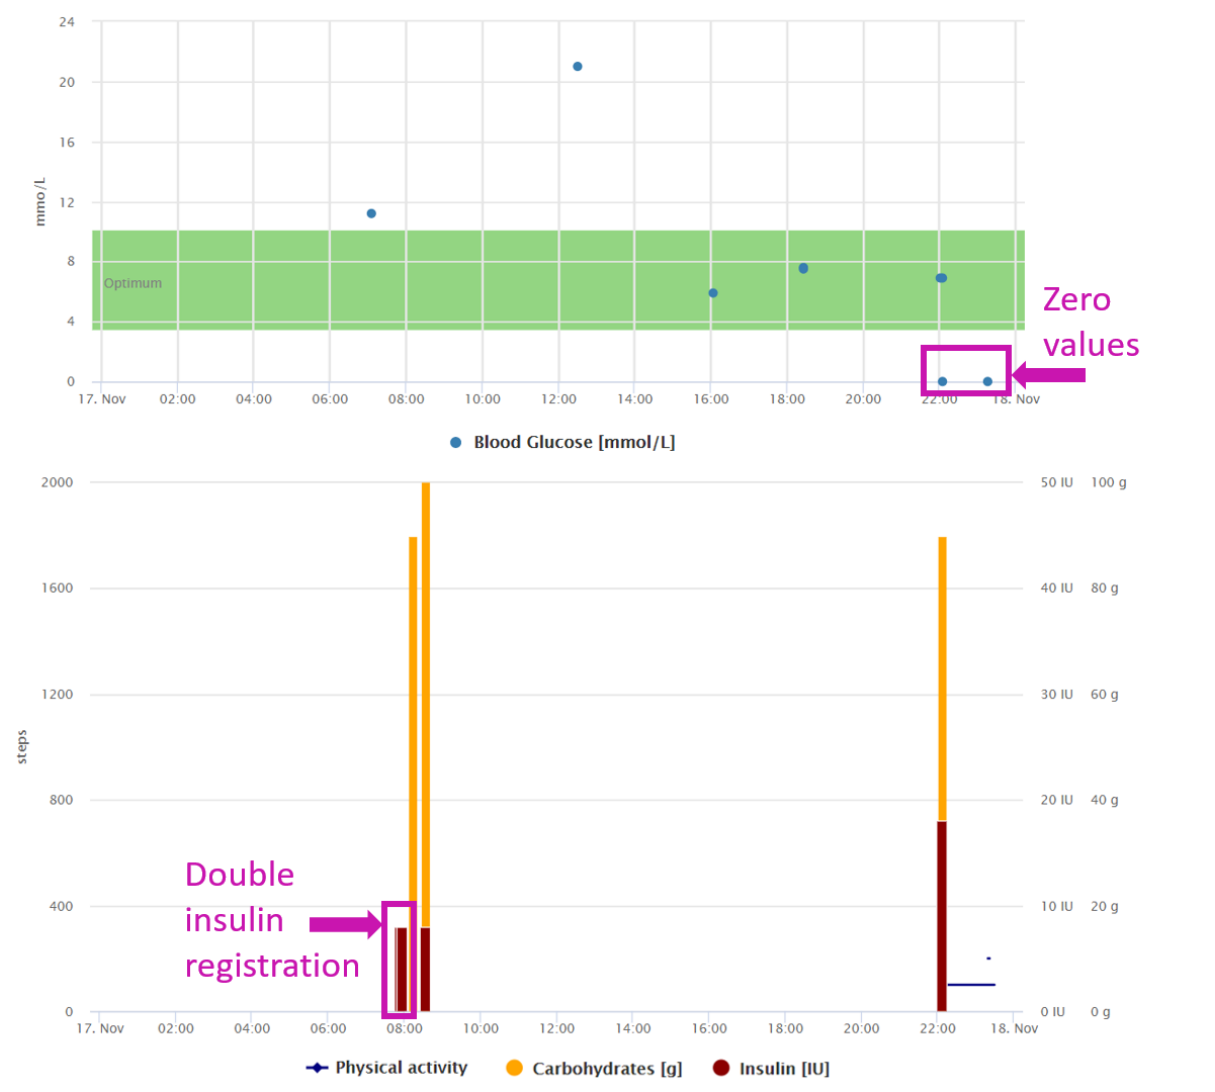
Figure 9. Graphical interpretation of 1-day data registrations of the patient from case study 6. We can see some accidentally duplicated or zero values because of the patient’s inability to operate the mobile